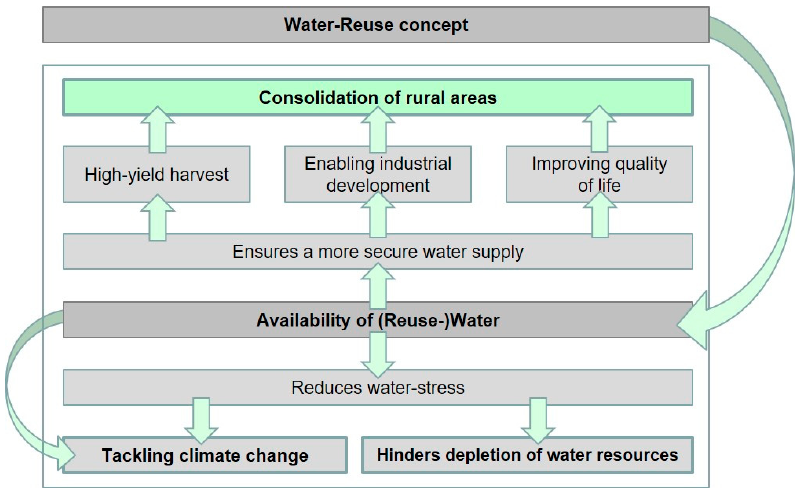
Figure 1. Water-reuse concept as a key element for strengthening rural areas (own figure).